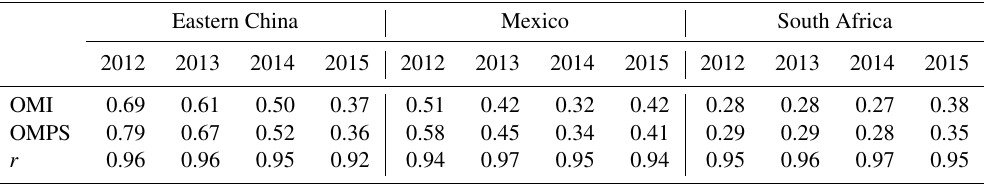
Table 2. The averaged SO 2 loading (unit: DU) in 2012–2015 from OMI and OMPS and their spatial correlations, r , for three regions: eastern China, Mexico, and South